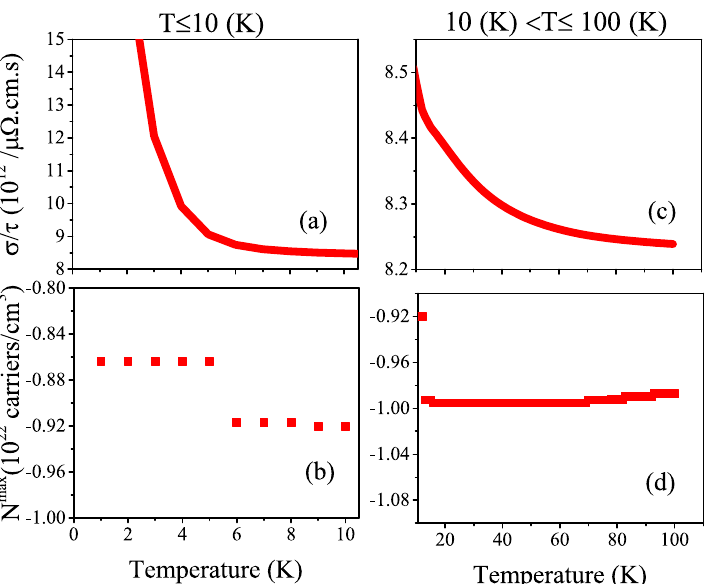
Figure 10. Maximum values of spin up electrical conductivity per relaxation time ( τ ), i.e., σ max /τ of electron/ hole doped CeIn 3 versus temperature for ( a ) T ≤ 10 K and ( b ) 10 K < T ≤ 100 K calculated using GGA+U with U eff = 5.5 eV for the P = 0 pressure. Doping levels related to the σ max /τ are displayed in the ( c ) and ( d ) panels for T ≤ 10 K and 10 K < T ≤ 100 K, respectively.